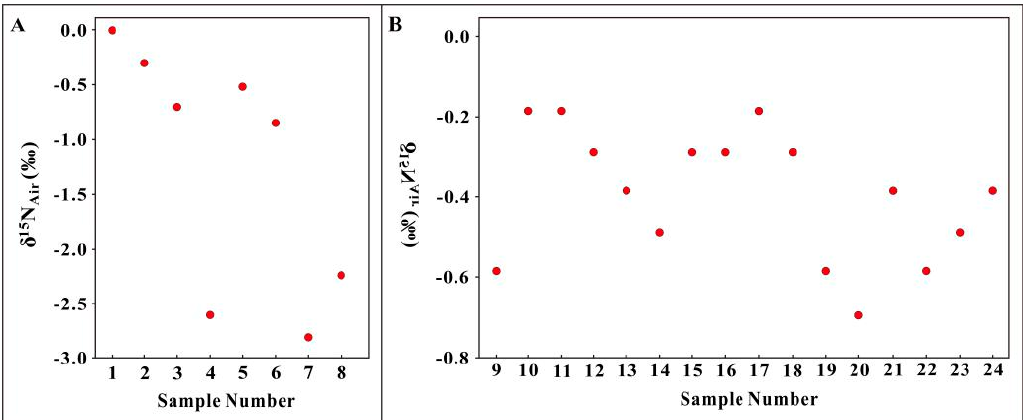
Figure 3. Results of nitrogen isotope analysis. ( A ) Niutitang Formation gas samples in the Youye-1 well; ( B ) Wangyinpu and Guanyintang Formations gas samples in the Jiangye-1 well. The gas sample information can be seen in Table 1.